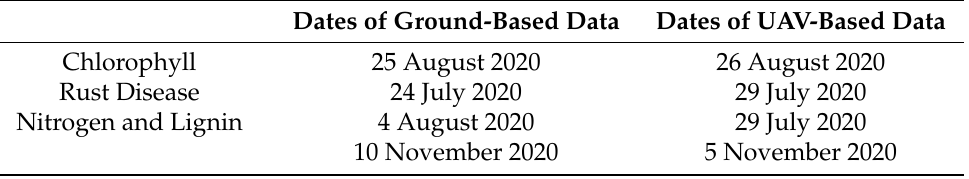
Table 4. Ground-based and UAV-based data collection for chlorophyll, rust, nitrogen, and lignin content (2020 growing season,